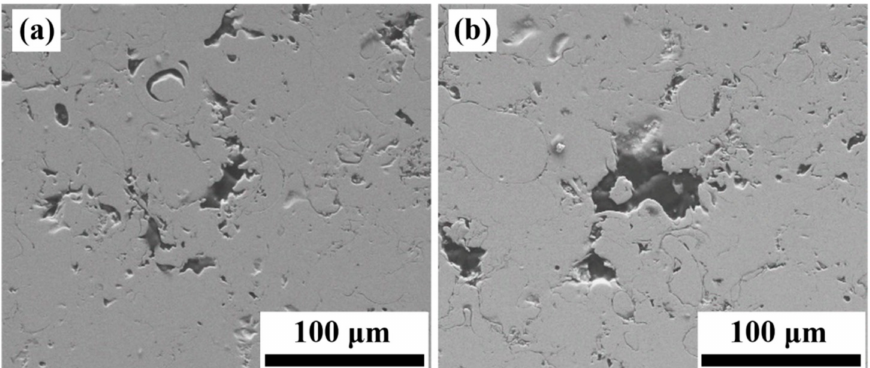
Figure 7. The morphologies of the cross section for the Fe-based AMCs after potentiodynamic polarization tests. ( a ) 30 ◦ C 0.35% NaCl solution and ( b ) 70 ◦ C 3.5% NaCl